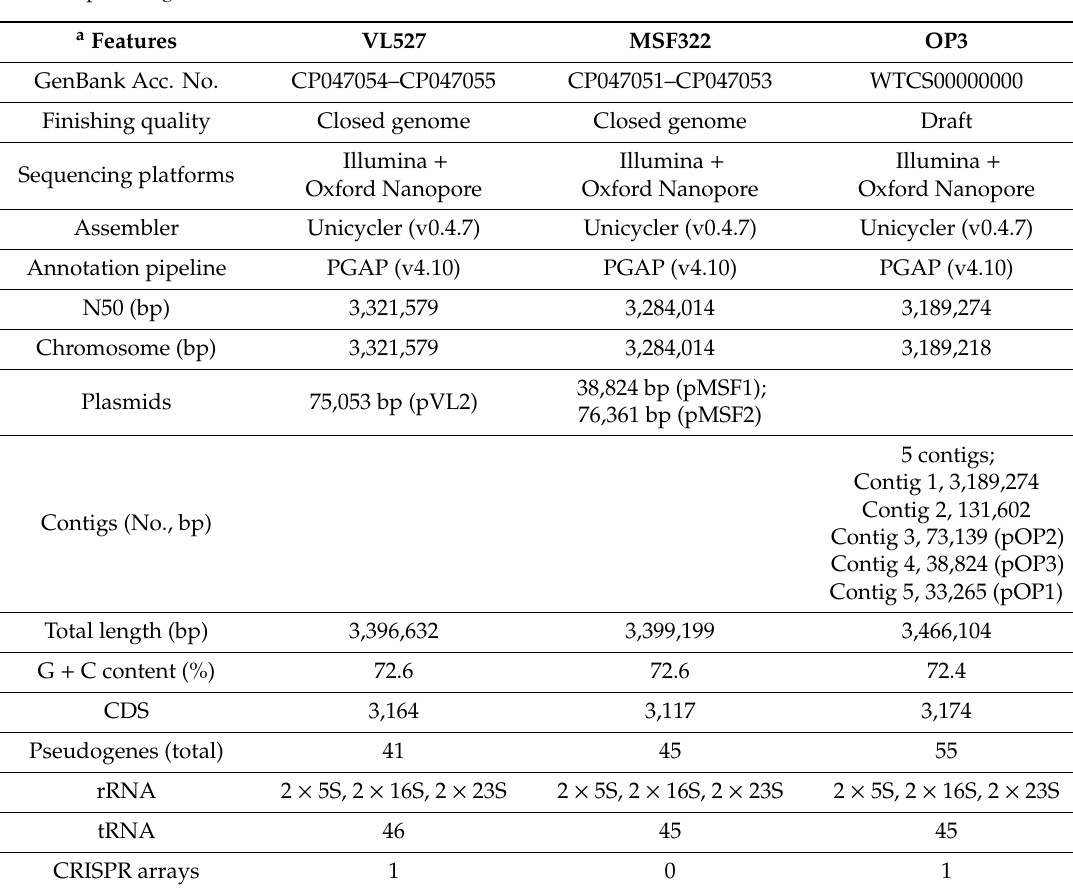
Table 3. Genomic features and assembly statistics for the whole-genome sequences of C. michiganensis subsp. michiganensis strains VL527, MFS322, and